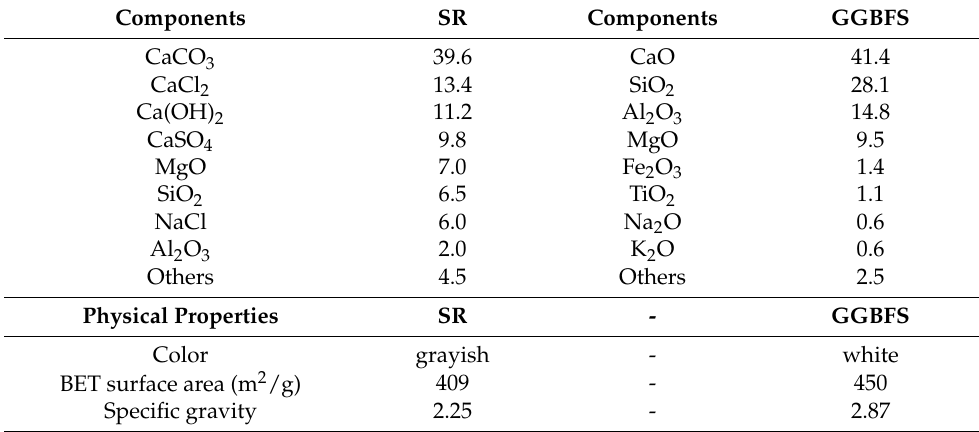
Table 1. Chemical compositions (wt.%) and physical properties of SR and GGBFS